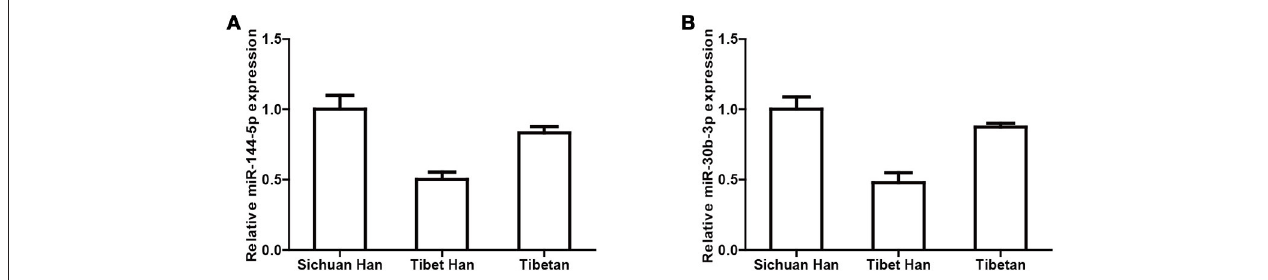
FIGURE 3 | Verification of miRNA sequencing results by real-time PCR. Cq values of miR-144-5p (A) and miR-30b-5p (B) were converted to relative concentrations normalized to U6 values and were calculated using the comparative Cq method.